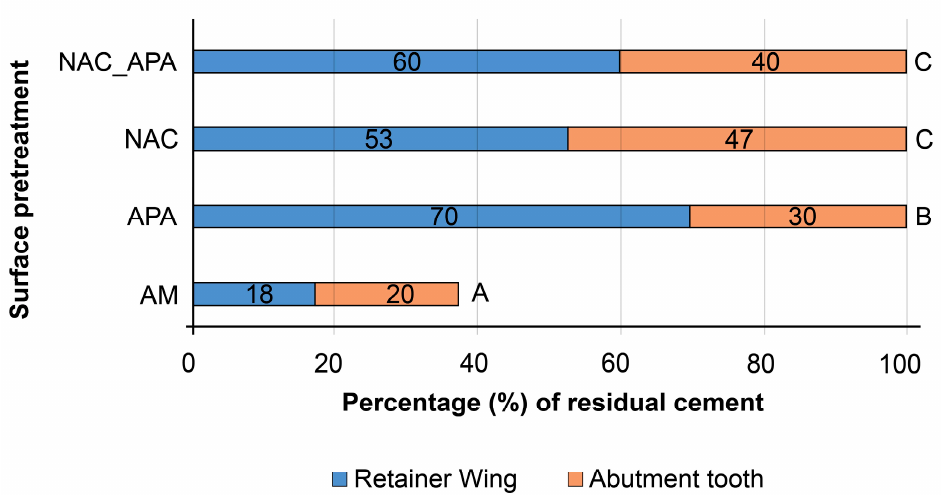
Figure 6. Mean percentages of retainer wing and abutment tooth bonding area covered with cement residue after quasi-static loading of aged groups. The same upper-case letters on the right side of each bar denote no statistical differences between the groups ( p < 0.05). AM , as-machined; APA , airborne-particle abrasion; NAC , nanostructured alumina coating.